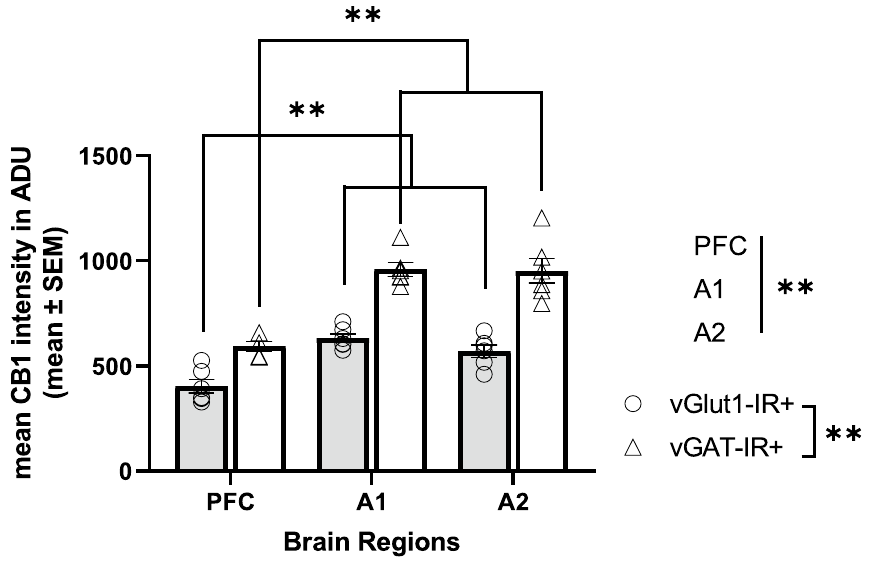
Figure 5. Mean CB1R intensity within excitatory (vGlut1-IR +) and inhibitory (vGAT1-IR +) cell types across three brain regions of the postmortem human cortex. Each individual data point represents mean intensity averaged across all sampled sites across a cortical layer. There was a main effect of cell type, p < 0.001, main effect of brain region, p < 0.001, and a significant cell type × brain region interaction, p < 0.001. Post hoc analysis indicated significantly lower mean CB1R intensity within the PFC for both excitatory and inhibitory populations compared to the primary and association auditory cortex, p < 0.001 for all comparisons. Straight lines indicate main effects across groups. Brackets indicate post hoc pairwise comparisons. ** p < 0.001. Error bar denotes SEM. PFC = prefrontal cortex, A1 = primary auditory cortex, A2 = association auditory